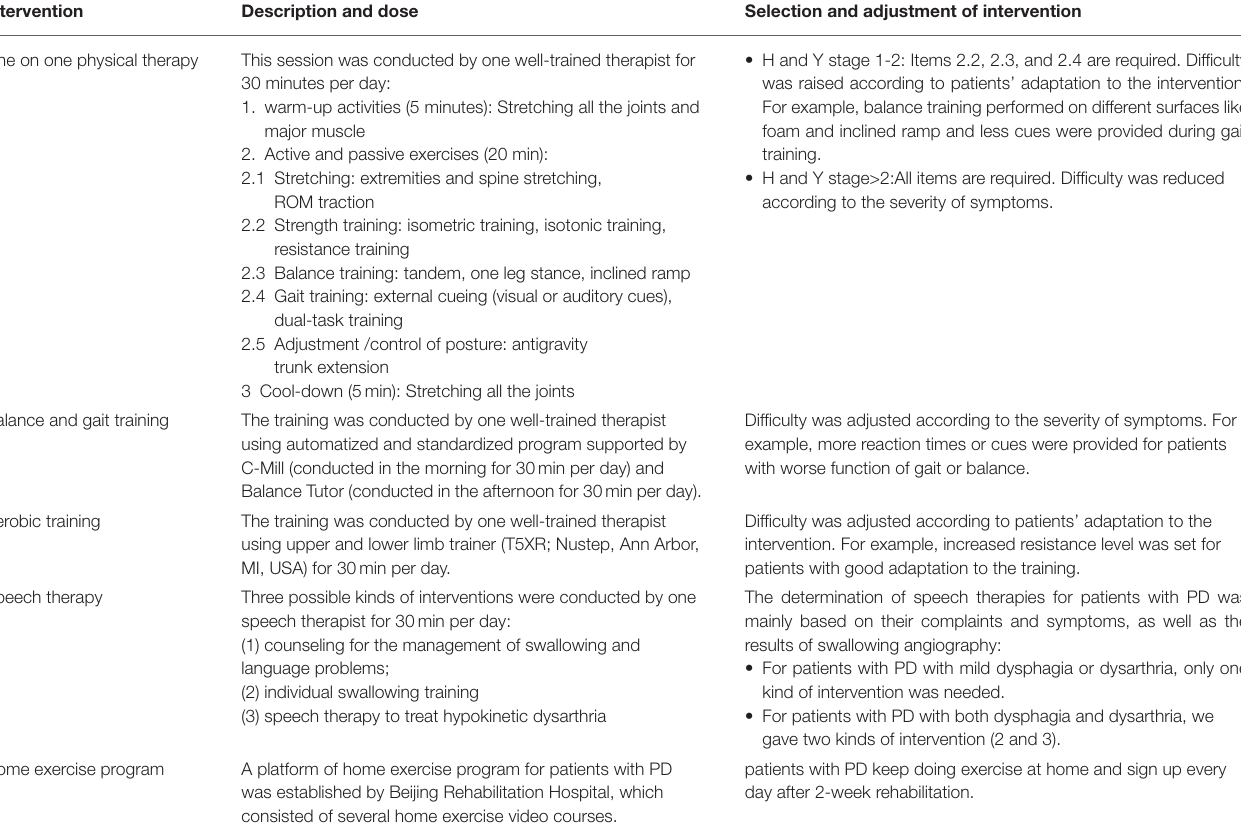
TABLE 1 | Illustration of rehabilitation procedure for patients with